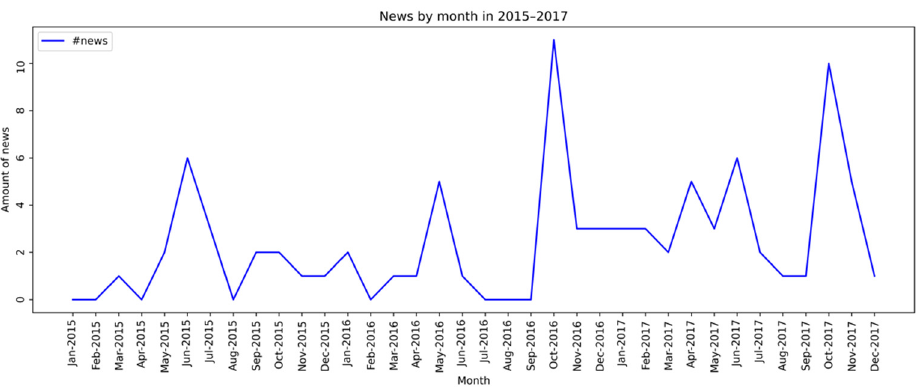
Figure 2. News month by month between 2015 and 2017 about syphilis.